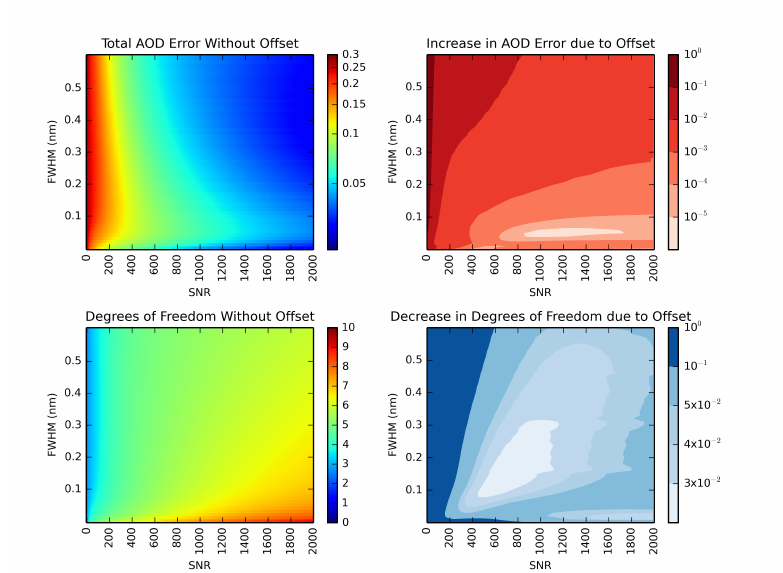
Figure 3. Total AOD error (top left panel) and DoF (bottom left panel) for the aerosol profile retrieval for scenario A; SZA 30 ◦ and albedo 0.5 as a function of continuum SNR and spectral resolution (as given by the FWHM of the ILS) without including an intensity offset in the retrieval. The panels on the right show the change in total AOD error and DoF when including an offset.